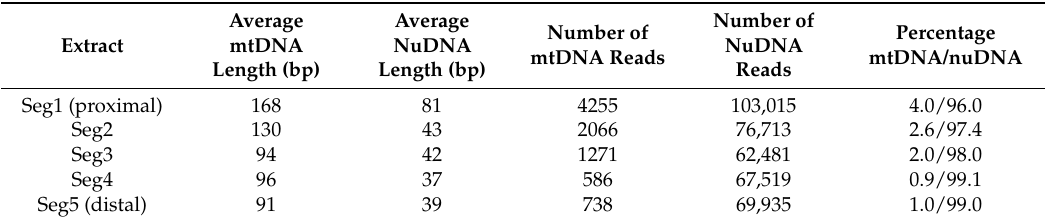
Table 4. Sequencing statistics for recent hair R7* purified with protocol B. This mapping used build hg38 as a reference. nuDNA: nuclear DNA.